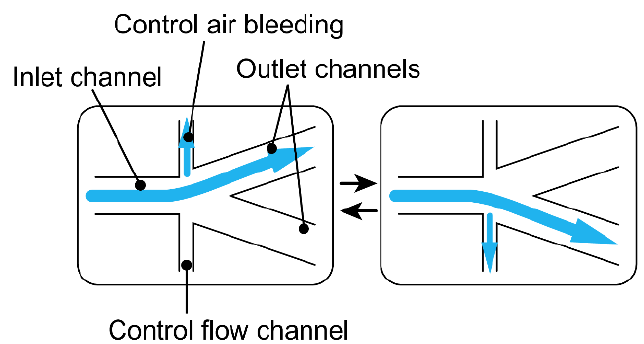
Figure 1. Schematic of the fluidic element used in this study. (Copyright by ASME — "Effects of Fluidic Control of Air-Flow Distribution on Staged Lean Jet Engine Burner," by Yoshida, Schneider, Hassa, Paper No: GT2016-57453).